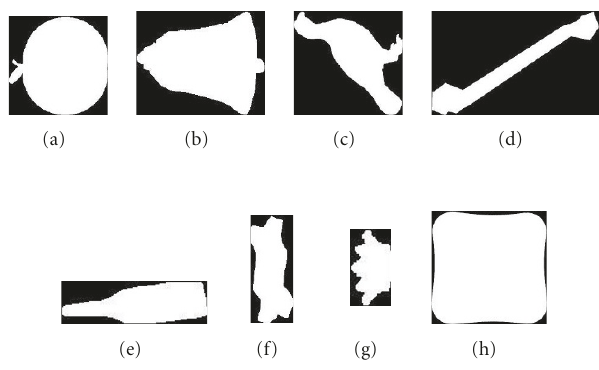
Figure 4: The database of smooth object images.